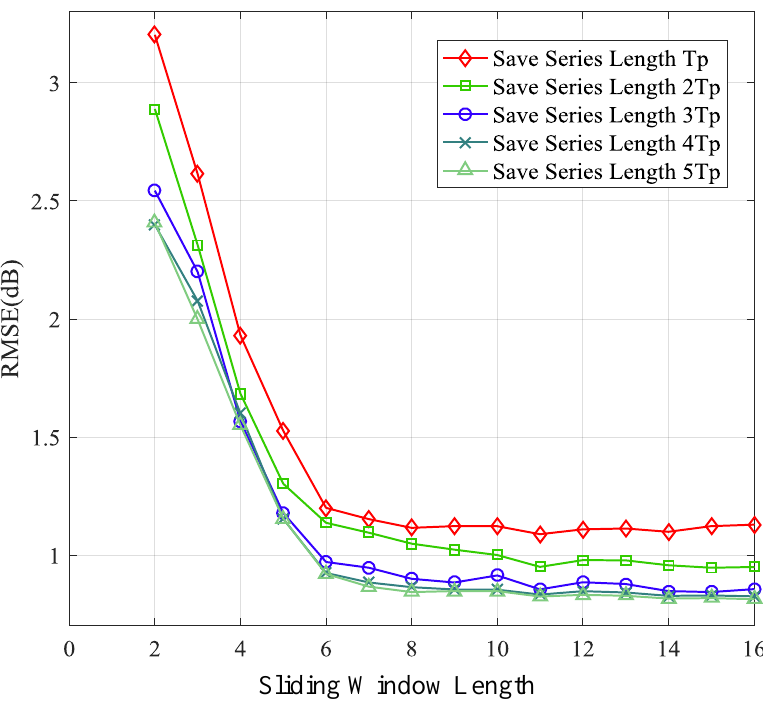
Figure 16. RMSE of 15-step ahead prediction with different length of sliding window and stored series.